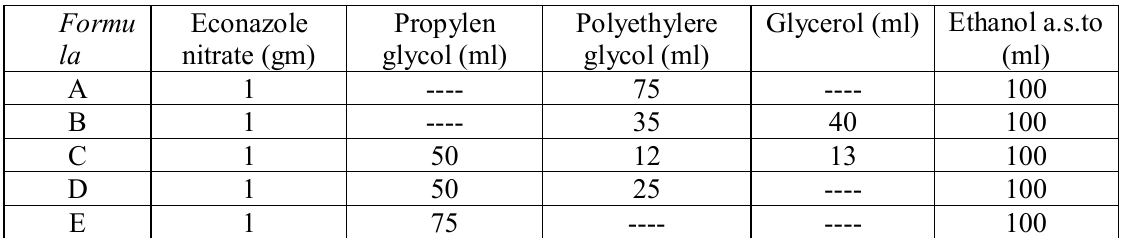
Table-1 Schedule of Different formulations of Econazole Nitrate as a topical Solution All formulas (A,B,C, Dand E ) were composed of Econazole nitrate (1%) and completed to 100 ml volume with